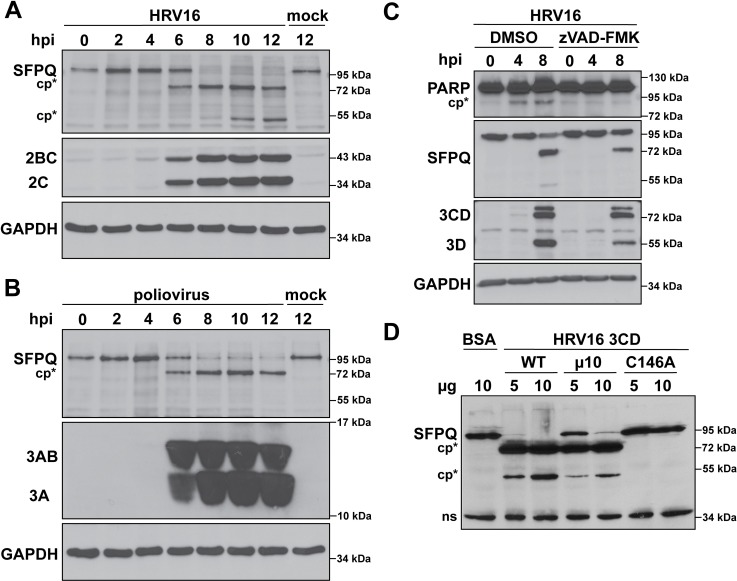
SFPQ is differentially cleaved during HRV16 or poliovirus infection of HeLa cells; cleavage is independent of caspase activity and is carried out by recombinant 3CD in vitro.(A) HeLa cells were mock- or HRV16-infected (MOI 10), cell lysates were generated at the indicated times, and lysates were subjected to Western blot analysis. SFPQ cleavage products are indicated (cp*). HRV16 2C and its precursor 2BC were used as indicators of infection and GAPDH was used as a loading control. (B) HeLa cells were mock- or poliovirus-infected (MOI 10) followed by the generation of cell lysates at the indicated times, and which were then subjected to Western blot analysis. The single SFPQ cleavage product is indicated as in (A). Poliovirus 3A and its precursor 3AB served as markers of infection and GAPDH was used as above. Poliovirus and HRV16 infections were both carried out at 34°C. (C) HeLa cells were infected with HRV16 in the presence or absence of 50 μM zVAD-FMK after which lysates were generated at the indicated times and subjected to Western blot analysis. SFPQ cleavage was observed with or without zVAD-FMK. HRV16 3D/3CD and GAPDH were used as above. Cleavage product of poly(ADP-ribose) polymerase 1 (PARP) is indicated (cp*). Data are representative of at least two independent experiments. (D) HeLa cell nuclear extract was incubated with bovine serum albumin (BSA) or different forms of recombinant HRV16 3CD and subjected to Western blot analysis. Cleavage of SFPQ (cp*) was observed in the presence of wild type (WT) 3CD and a form of 3CD containing a mutation in the 3C/3D autoproteolysis site (uncleavable, μ10). Catalytically inactive 3CD (C146A) did not cause cleavage of SFPQ. Hpi: hours post infection; ns: non-specific.